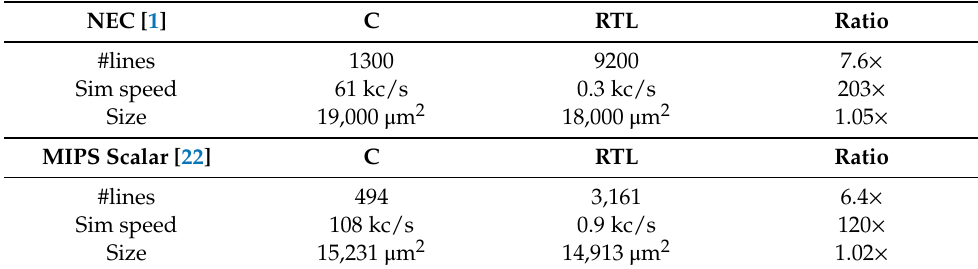
Table 4. Processor design comparison (C vs.